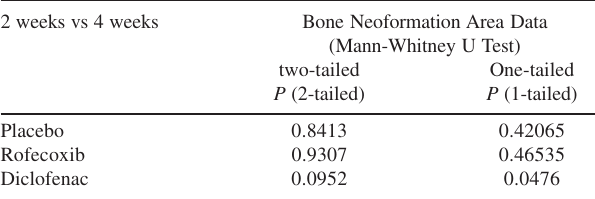
Table 8 - Total area (µm²) ofAbsolute Values of bone neoformation, by animal, area of the groups with at 2 weeks